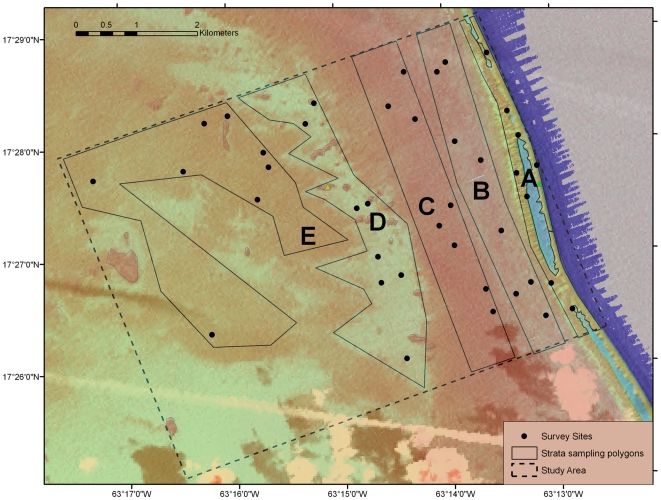
Saba Bank sampling strata and survey sites.The sampling locations are shown on a composite image of depth and ocean color. Polygons labeled A to E show the sampling strata which correspond to five habitat types: (A) fore reef, FR; (B) outer reef flat, ORF; (C) inner reef flat, IRF; (D) softbottom lagoon, LSB; (E) hardbottom lagoon, LHB. Black dots show sample locations.